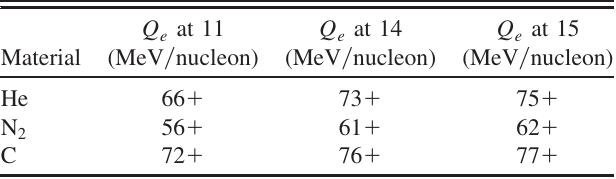
TABLE IV. Equilibrium charge state of uranium ion Q e in the , and C at 11, 14, and 15 MeV = nucleon . The data gases of He, N 2 for He gas were extracted from the intersections of the lines for the measured cross sections of e-loss and e-capture. The data for gas and a carbon foil were obtained from Refs. [20,21]. N 2